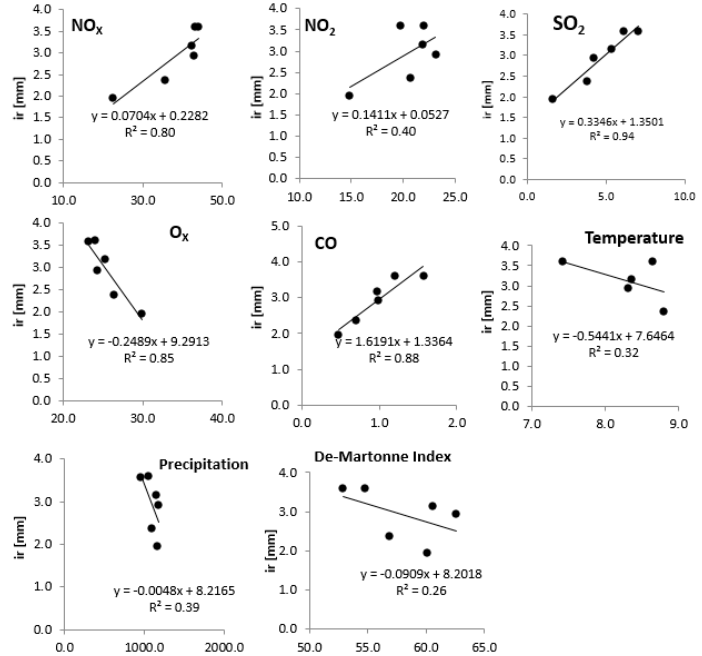
Figure 7. Relationships of mean environmental pollution (NO X , NO 2 , SO 2 , O X , CO) and mean climate data (temperature, precipitation, de Martonne-Index) with average radial growth of A. sachalinensis in Sapporo, Japan in five-year time steps from 1983 to 2012 and an added regression line with regression coe ffi cients and adjusted R 2.